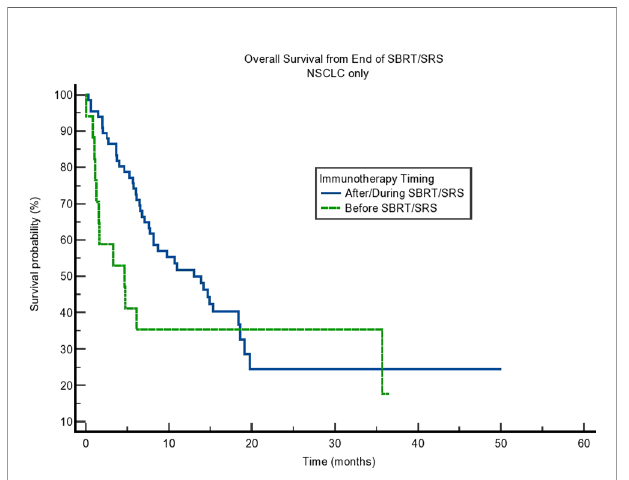
FIGURE 2 | Kaplan – Meier curve showing overall survival (OS) from the end of treatment. OS separated based on immunotherapy given during/after stereotactic body radiotherapy (SBRT)/stereotactic radiosurgery (SRS) compared to before SBRT/SRS. p =